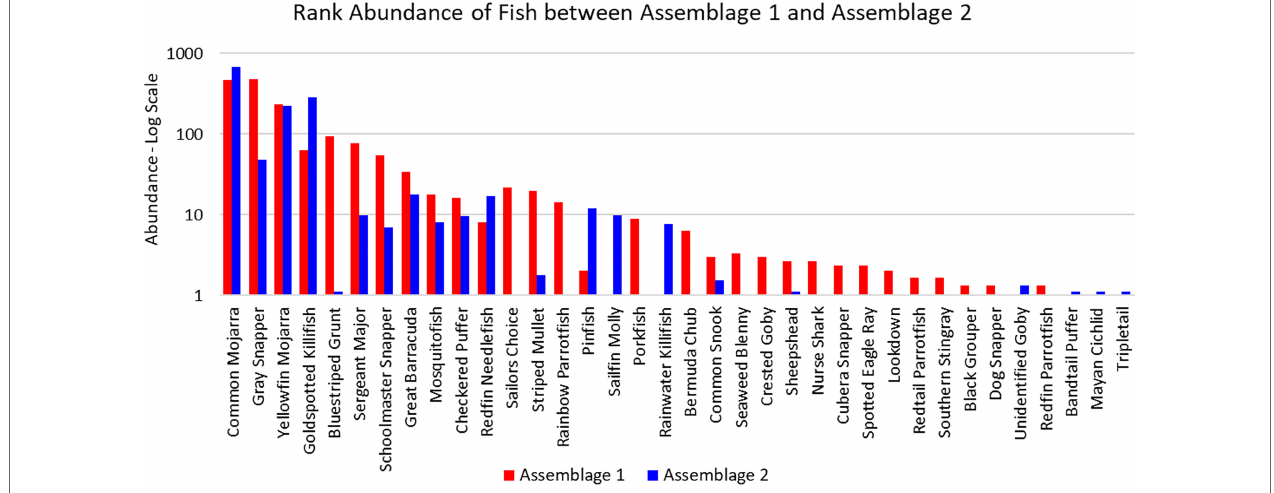
FIGURE 5 | Ranked abundance of fish species found in Assemblages 1 and 2. The abundances are averaged by the number of sites forming each assemblage and shown on a log